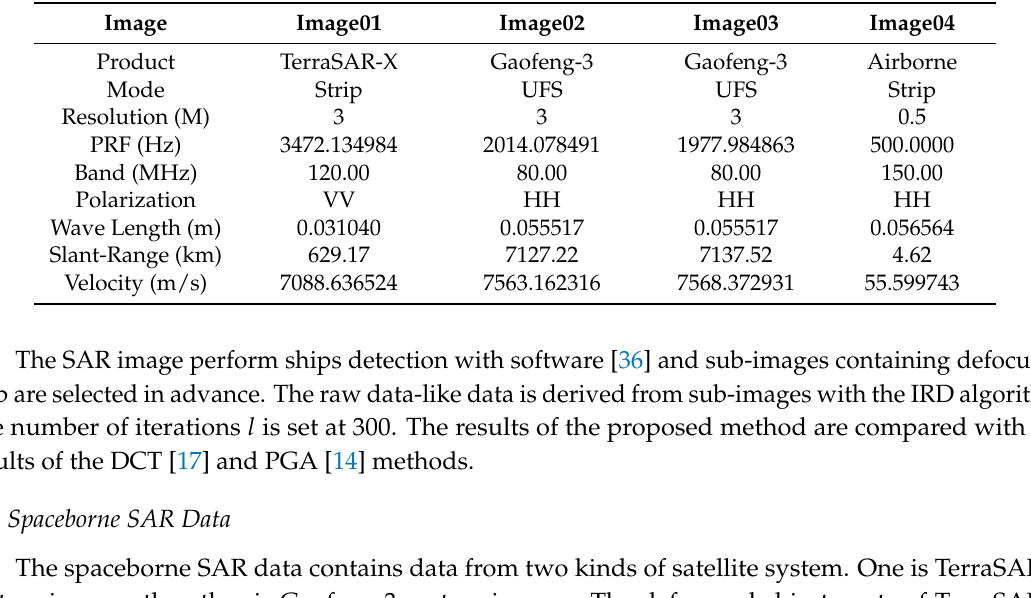
Table 1. The parameters of four SAR images.